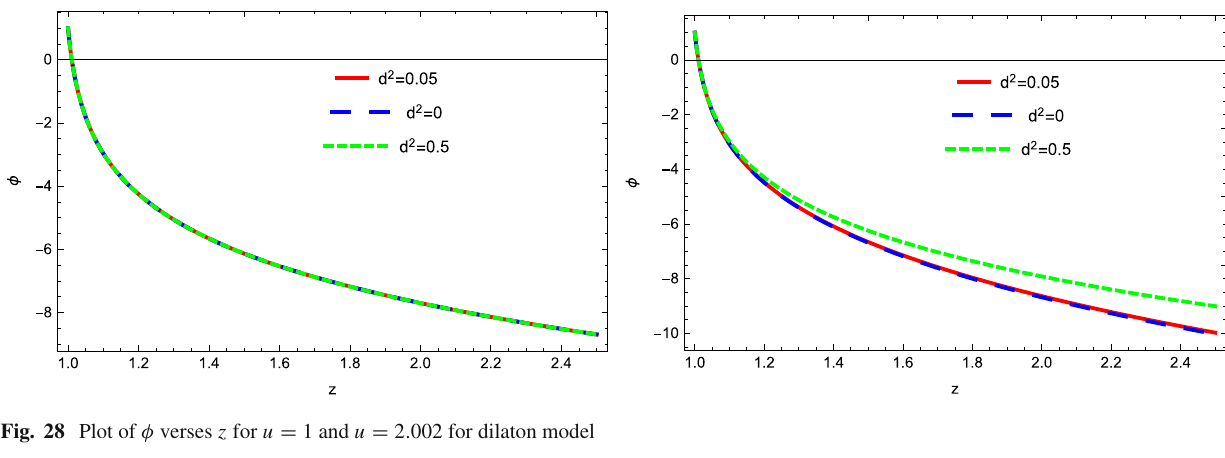
Fig. 28 Plot of φ verses z for u = 1 and u = 2 . 002 for dilaton model